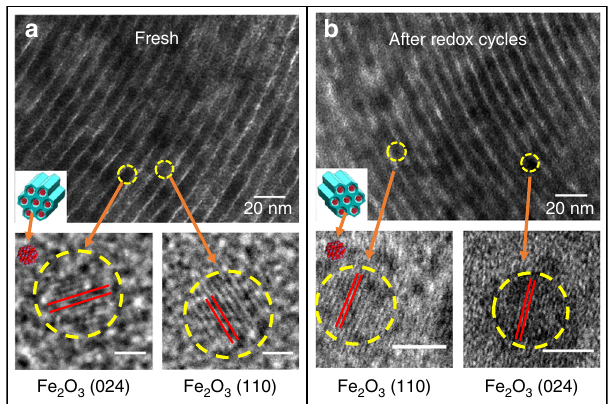
Fig. 2 Morphological characteristics of Fe 2 O 3 @SBA-15. a Fresh Fe 2 O 3 @SBA- 15 and HR-TEM images of two typical Fe 2 O 3 nanoparticles (Scale bar represents 1 nm); b Fe 2 O 3 @SBA-15 after 75 redox cycles and HR-TEM images of two typical Fe 2 O 3 nanoparticles (Scale bar represents 5 nm).